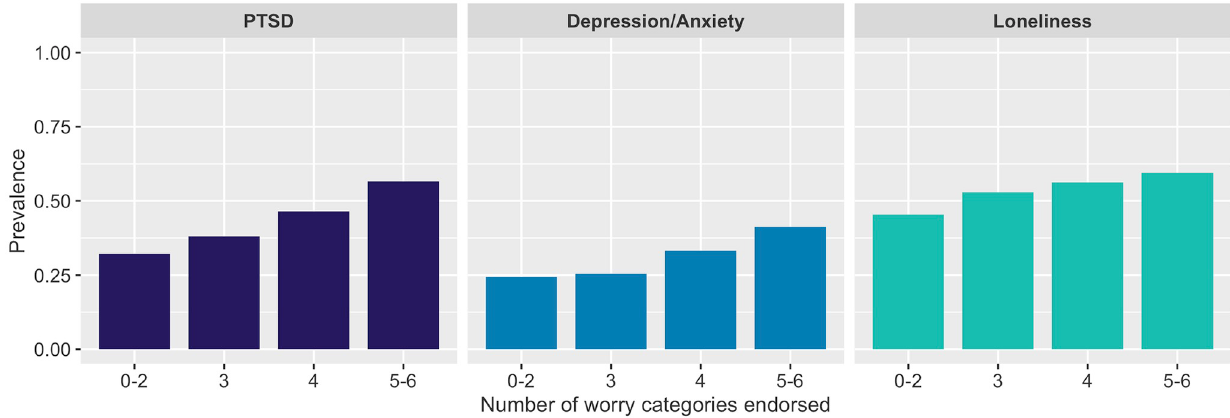
Fig 4. Prevalence of elevated symptoms of PTSD, depression/anxiety, and loneliness by the number of COVID-19-related worry categories endorsed by pregnant and postpartum women.